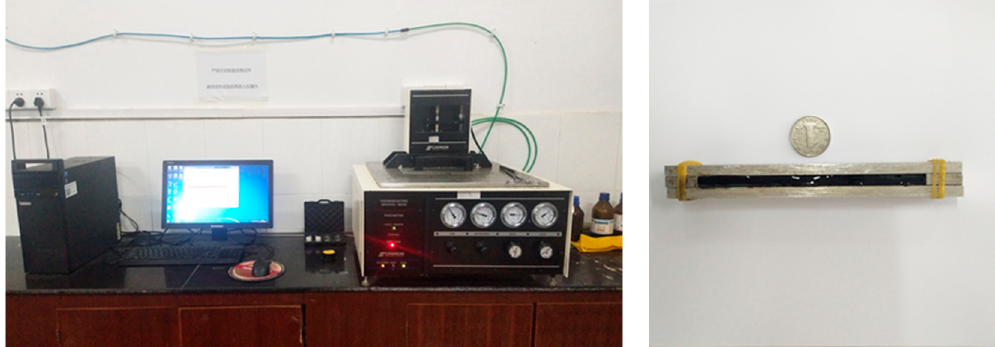
Figure 3. Beam bheometer (BBR) test equipment.